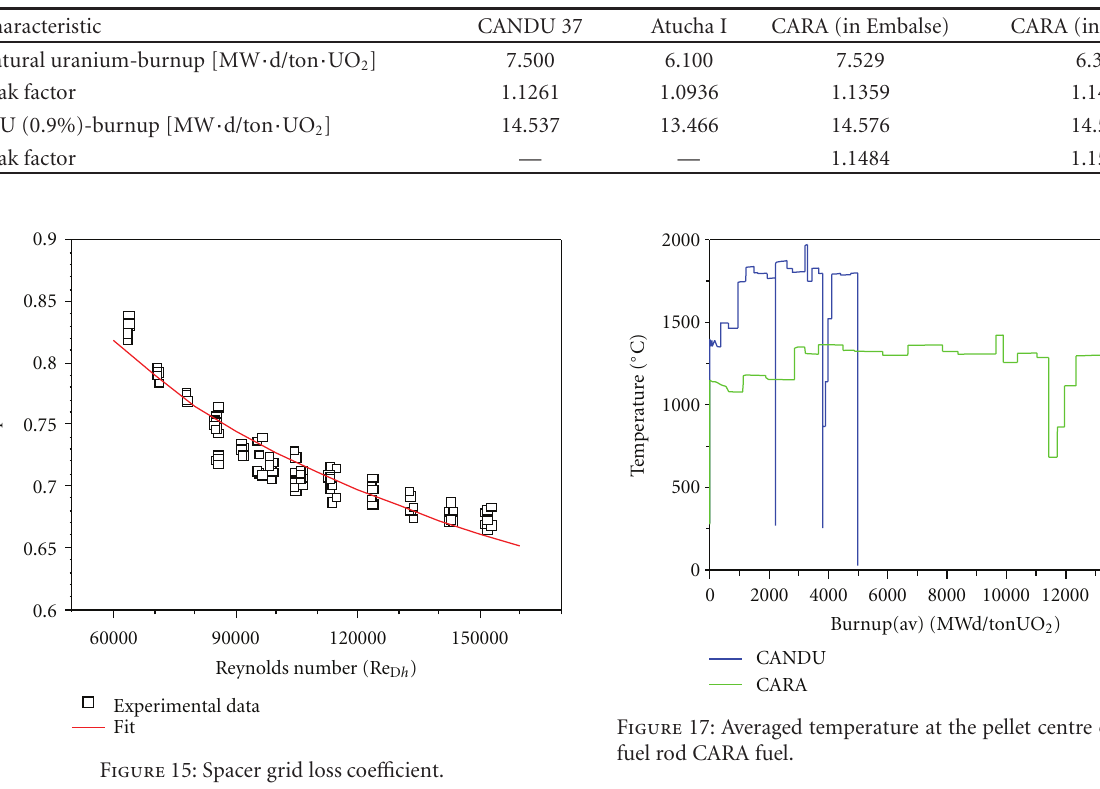
Figure 15: Spacer grid loss coe ffi cient.